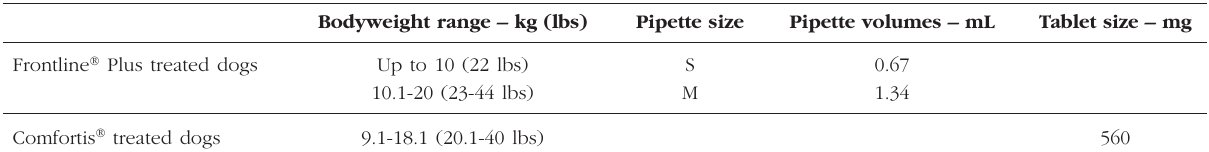
Table I. – Dosage of dogs in the treated